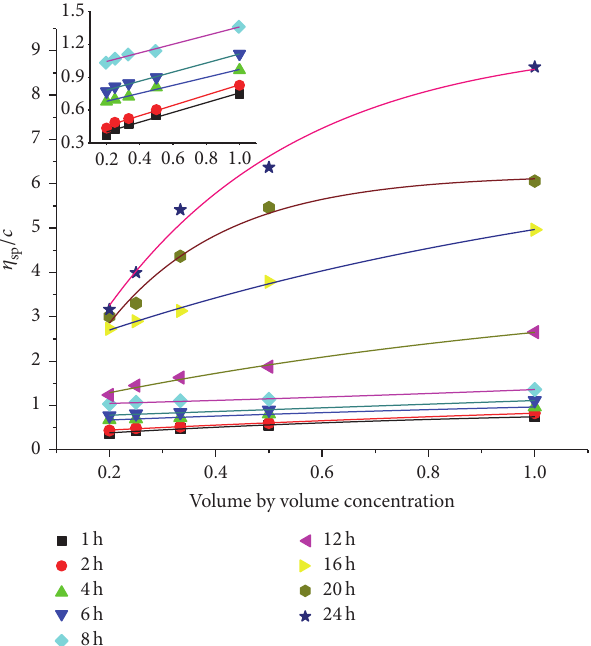
/𝑐 and volume by volume sp